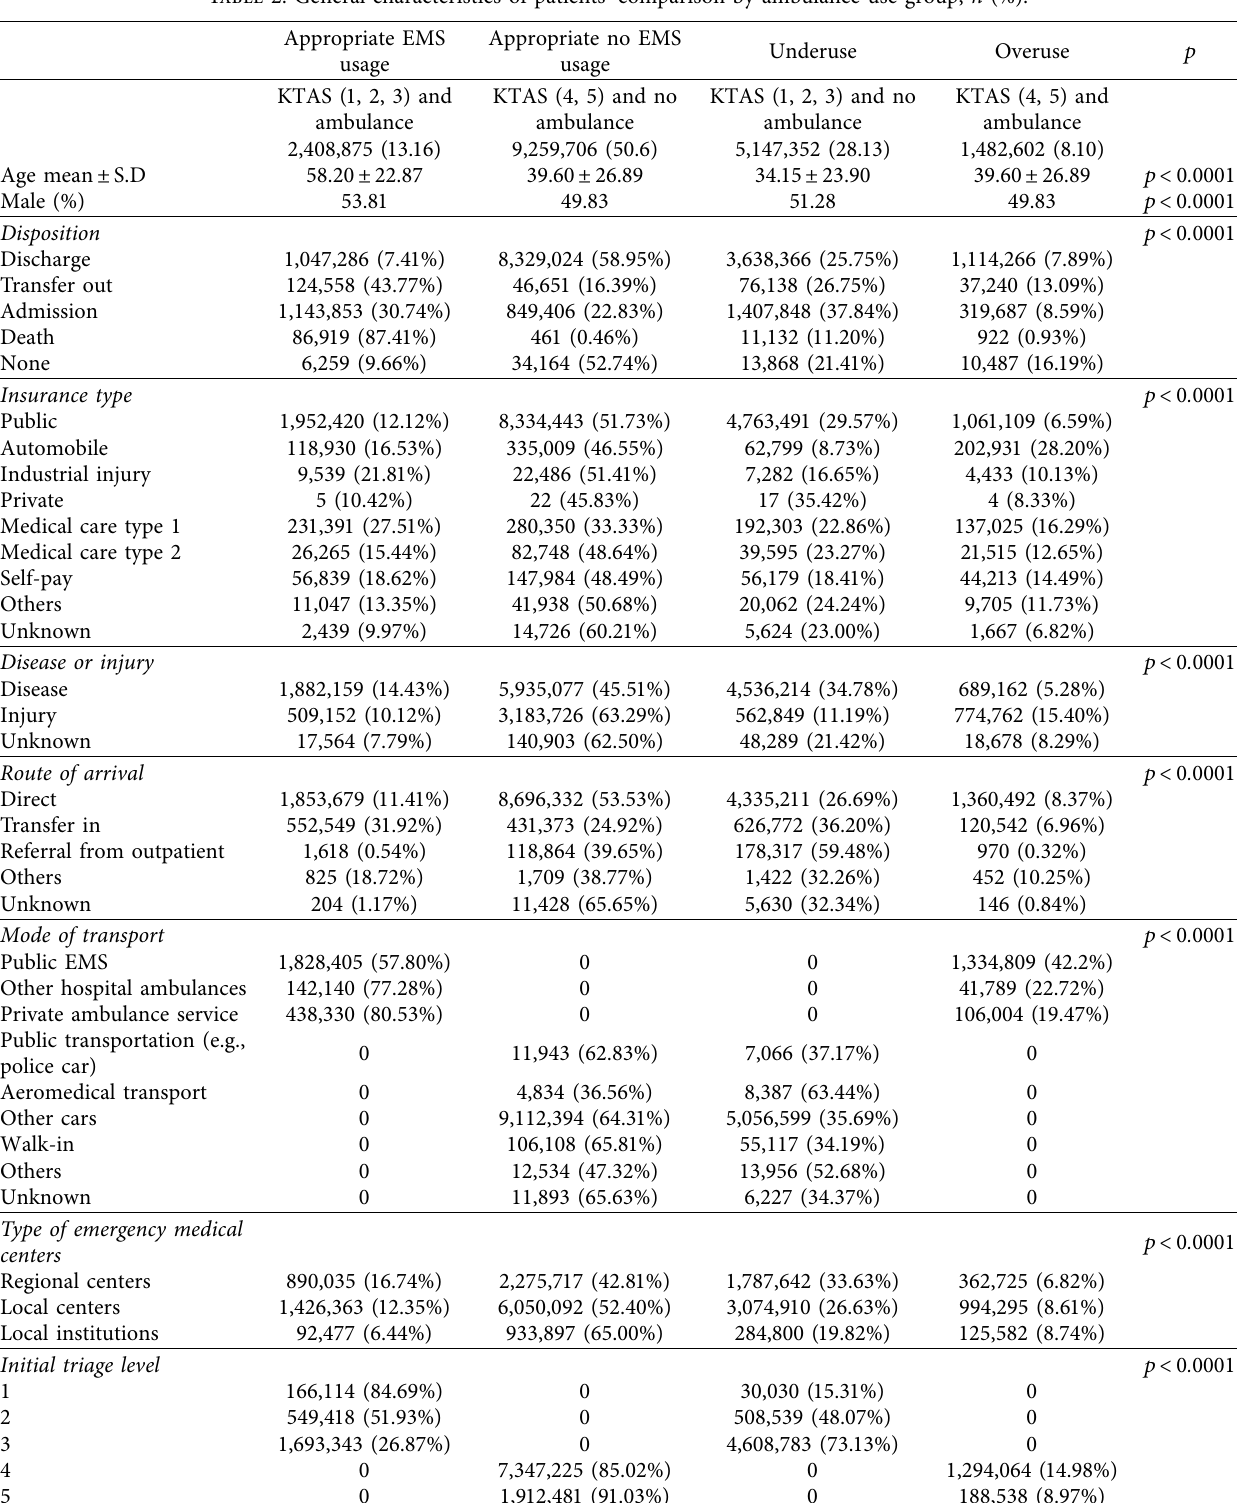
Table 2: General characteristics of patients’ comparison by ambulance use group, n